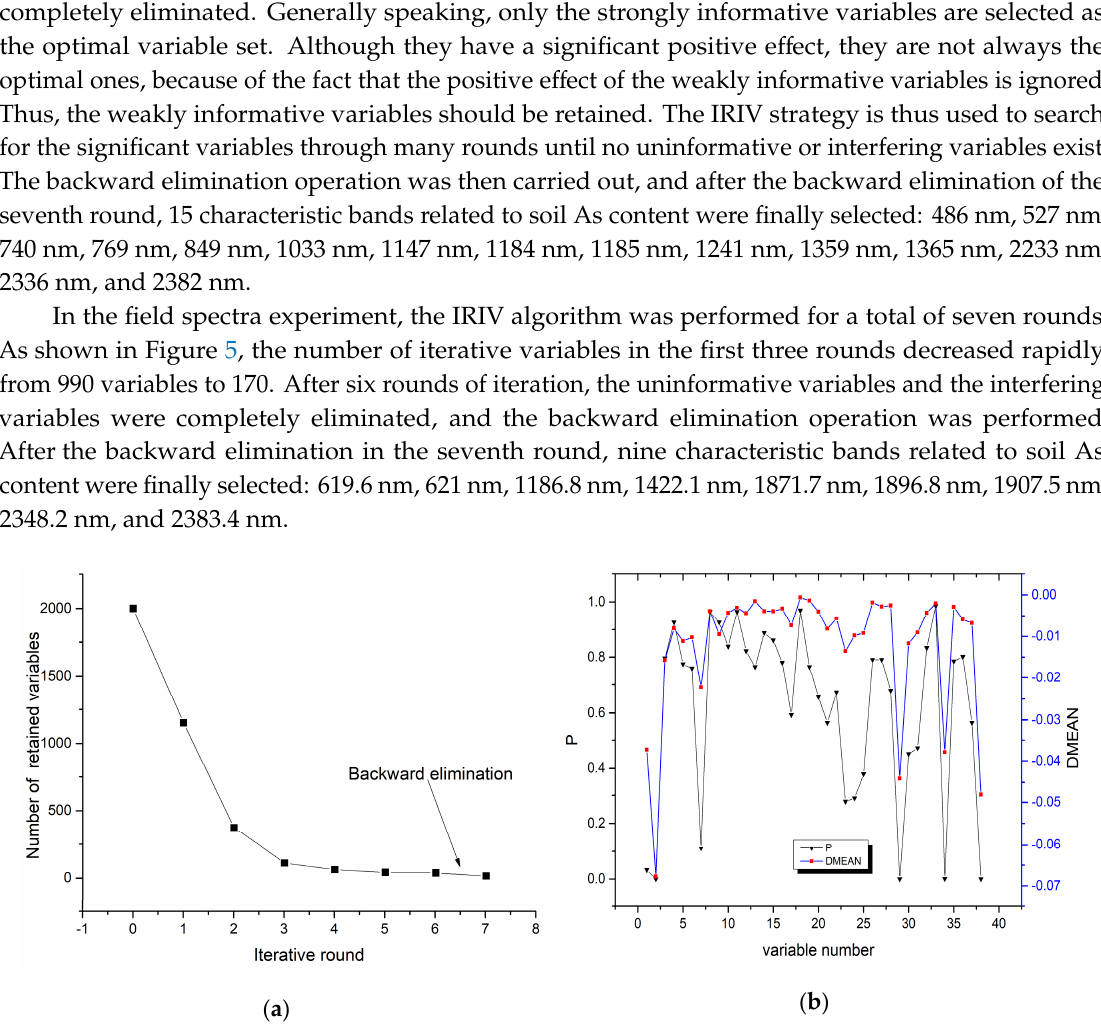
Figure 4. Iteratively retaining informative variables (IRIV) iterative process and wavelength type decision parameter values obtained using the laboratory spectral reflectance. ( a ) Number of retained variables in the iterative rounds of IRIV; ( b ) DMEAN and p value in the 6th iteration.